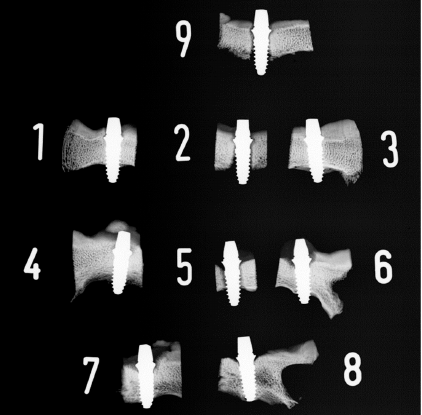
Figure 9. Microscope images after healing and histomorphometrical preparation. Upper row after 2 weeks of healing (1. Control, 2. CAP, 3. UV-light), middle row after 4 weeks of healing (4. Control, 5. CAP, 6. UV-light), lower row after 9 weeks of healing (7. Control, 8. CAP, 9. UV-light). BIC values ranged between 21.9 and 80.1% (Figure 10). Mean values decreased after four weeks of healing in all groups, but rose again after nine weeks of healing in all